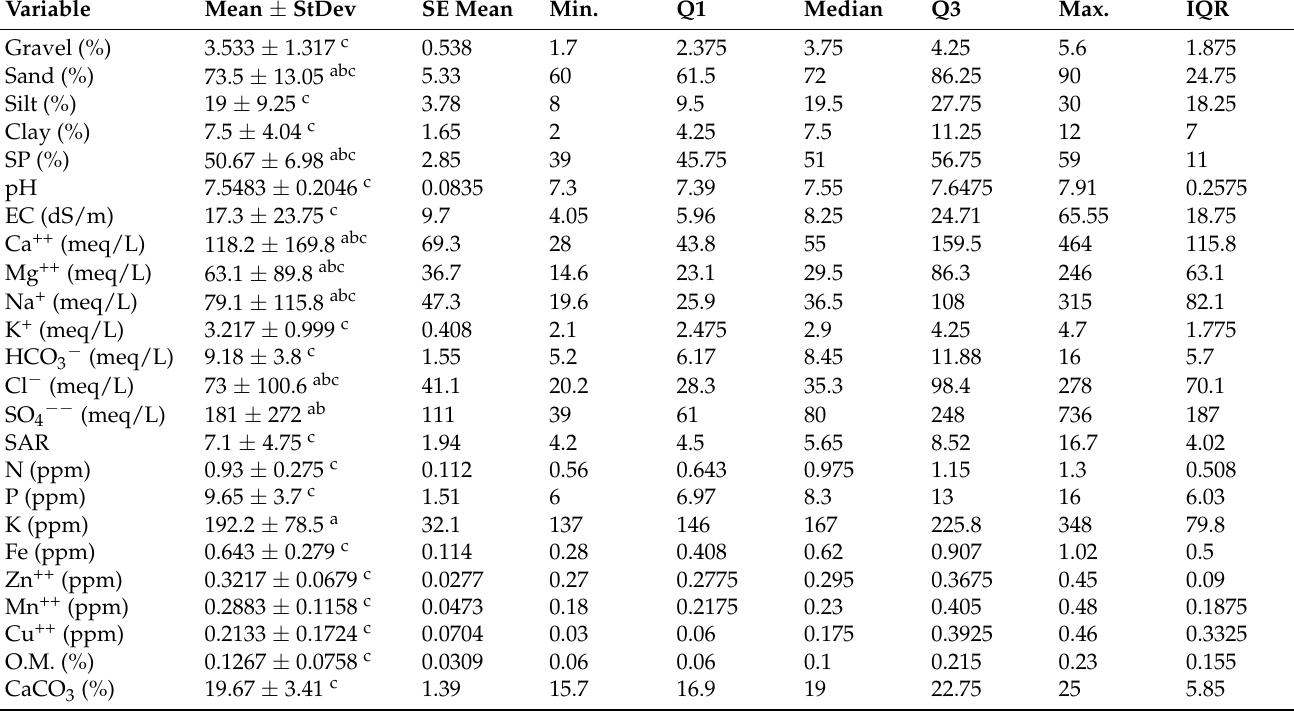
Table 6. Physicochemical soil properties of Ricinus communis . Where SP refers to Saturation Percent- age, and SAR refers to Sodium Adsorption Ration. Different letters represent significant